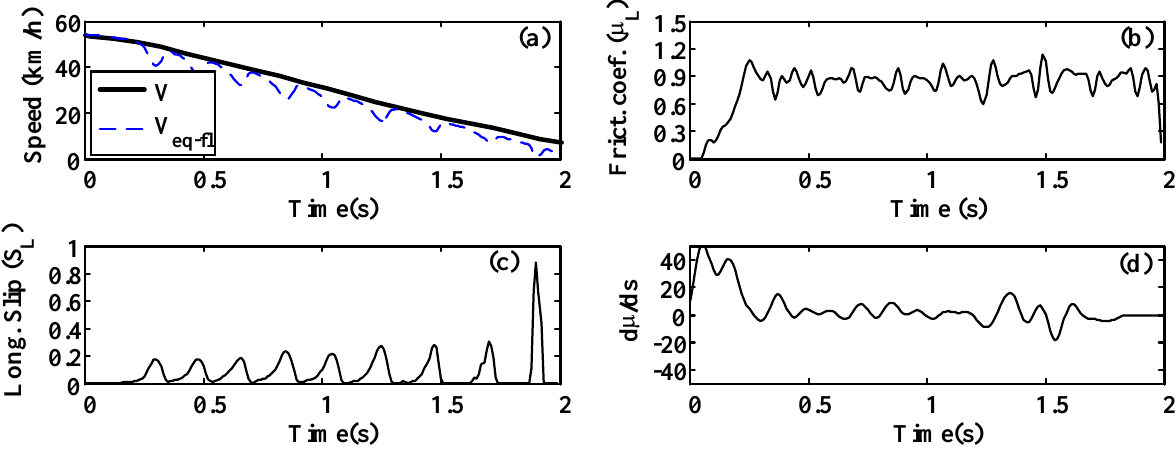
Figure 22. Wet asphalt. ( a ) Speed; ( b ) Friction coefficient; ( c ) Longitudinal slip; ( d ) Slope of µ–s curve.